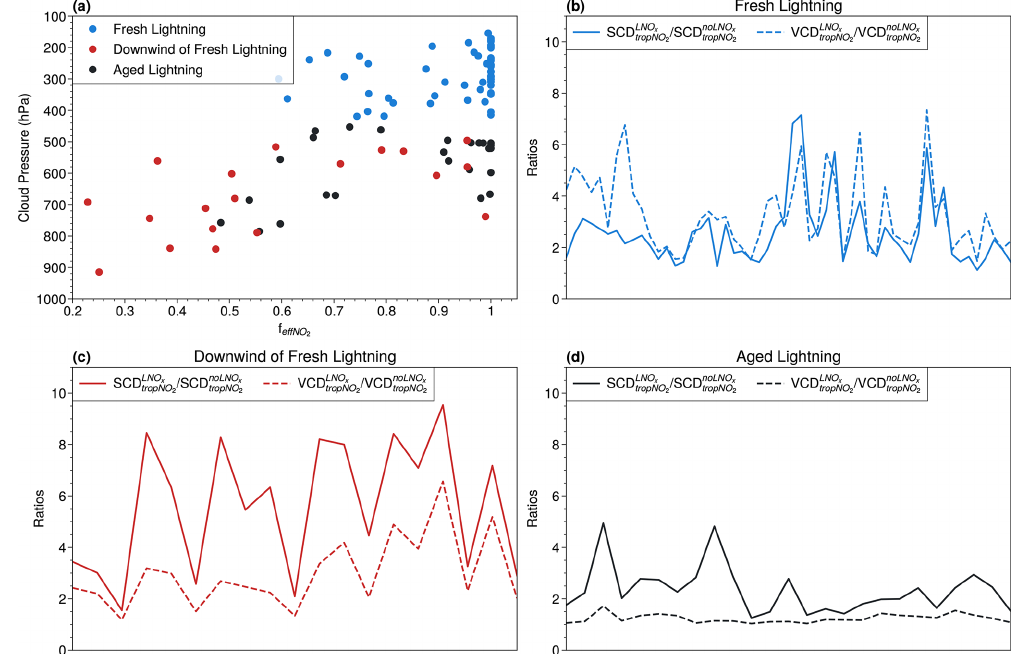
Figure 8. (a) The relationship between cloud pressure and cloud radiance fraction for three regions defined in Fig. 7: fresh lightning region, downwind of fresh lightning, and aged lightning area. (b–d) The a priori SCD LNO x pixels in these three regions. The LNO x superscript indicates that the a priori variable is calculated with LNO x (500molNO per flash), and the noLNO x superscript is without LNO x .